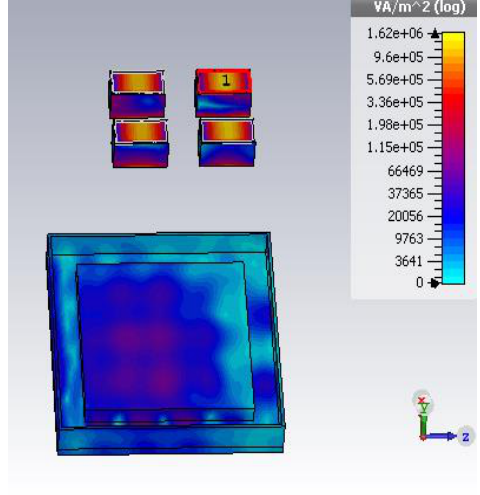
Fig. 4. Power flow distribution of a focused antenna array with non-phase